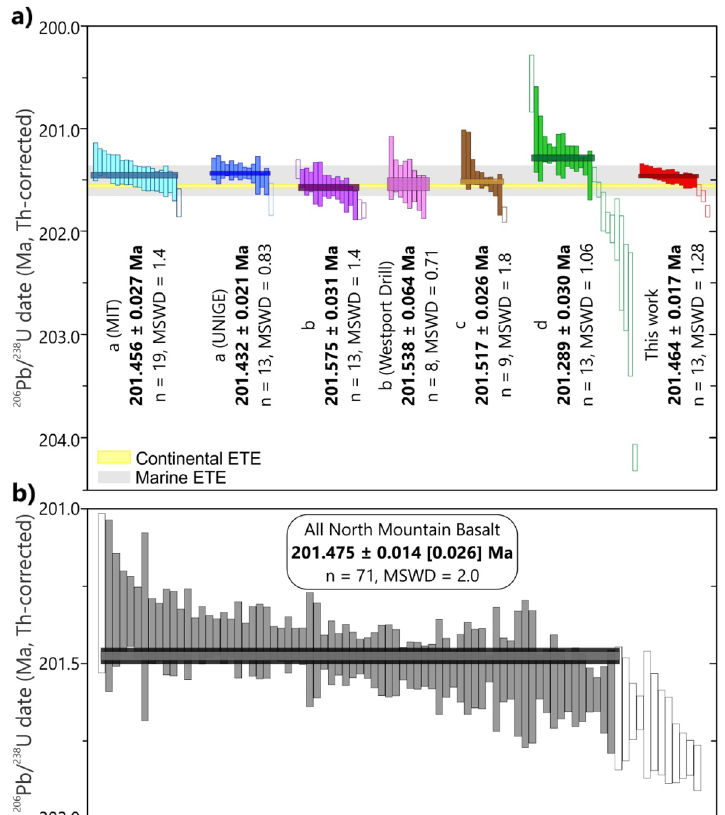
Figure 5. ( a ) Comparison of 230 Th disequilibrium-corrected ages for the North Mountain Basalt (NMB03 + Westport Drill core). All original data published by (a)—Ref. 4 , (b)—Ref. 6 ; (c)—Ref. 2 ; (d)—Ref. 10 and this work were corrected using a common Th/U magma ratio of 5.0 ± 0.5 (based on values from Ref. 49 . Ages from Ref. 4 were recalculated from previous EARTHTIME tracer calibration based on the corrections made by Ref. 7 . Blank boxes represent outlier crystals not included in weighted mean age calculations. Continental and marine ETE timing are from Ref. 6 and Ref. 7 , respectively. ( b ) Compilation of all analyses for a best estimate weighted mean age for the North Mountain Basalt, outlier crystals were removed by failing a modified version of the Thompson’s Tau rejection test. The uncertainty is shown as the weighted mean standard error, and also the inflated in quadrature by 0.011% dispersion from the ET100 U–Pb solution threshold in brackets.